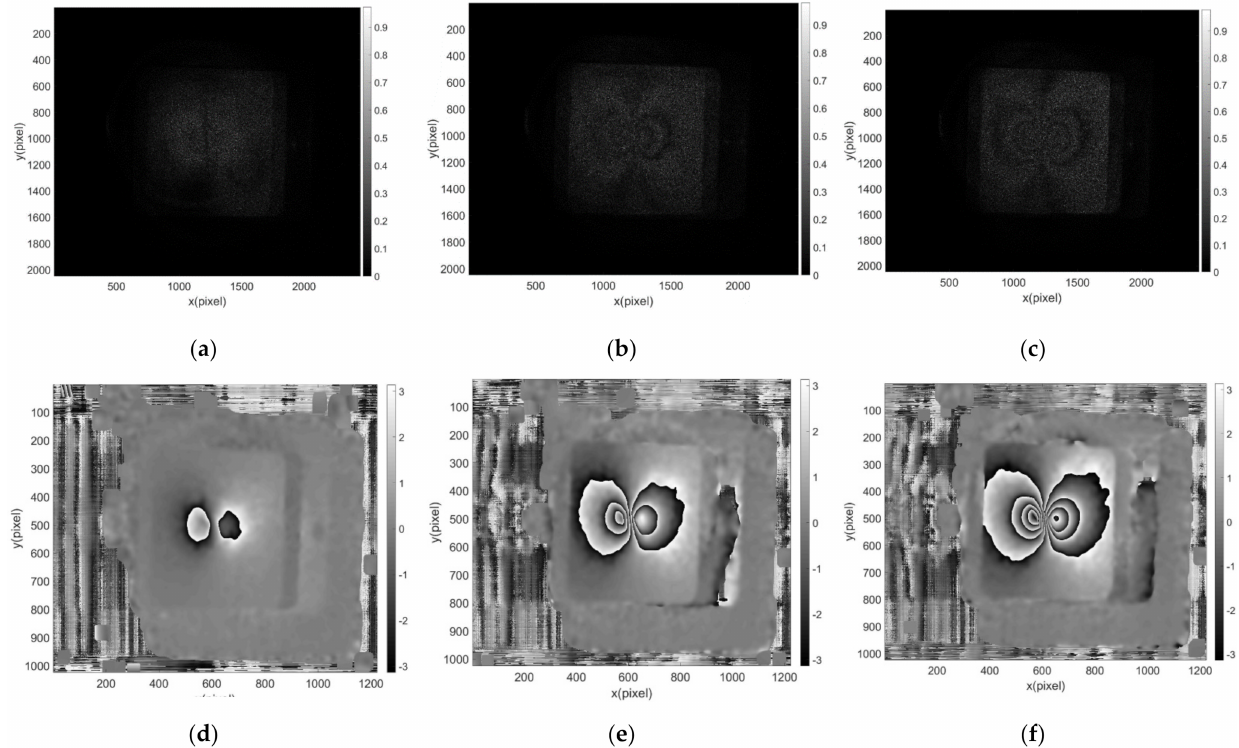
Figure 7. ( a – c ) Development of fringe patterns at time points 10th, 40th, and 70th frame in SPS-DS system; ( d – f ) Retrieved wrapped phase map at time points 10th (